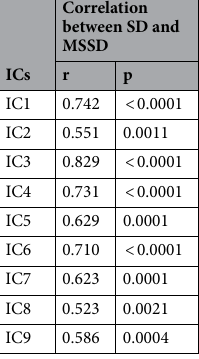
Table 1. Pearson correlations between brain variability measured by SD and MSSD. IC independent component, SD standard deviation, MSSD mean squared successive difference.